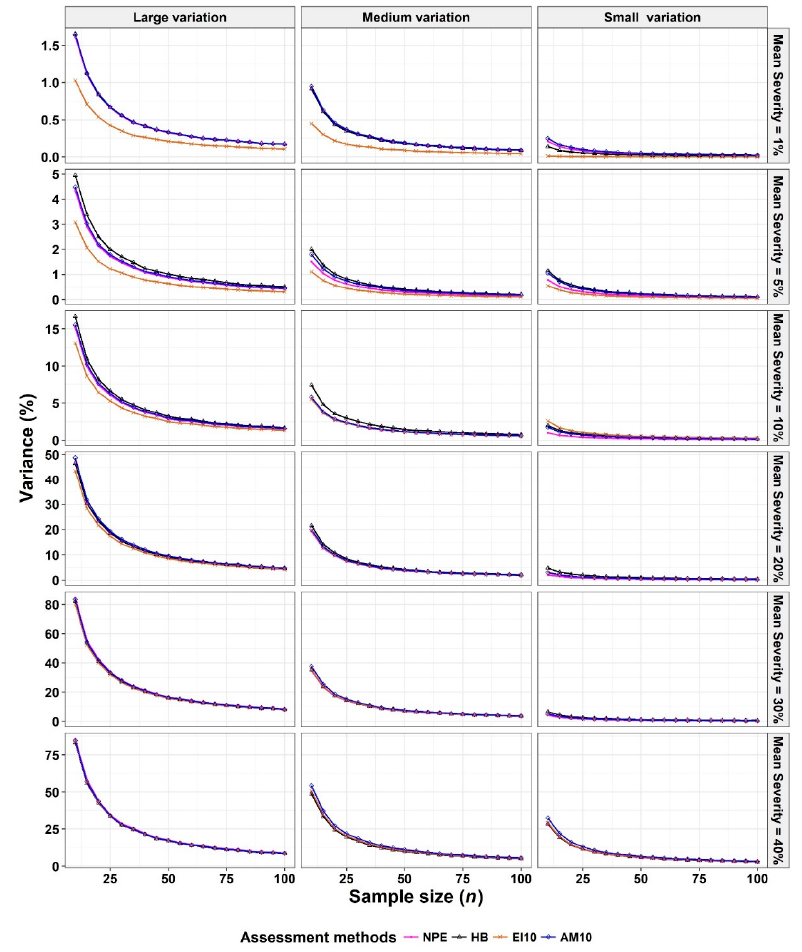
Figure 3. The relationships between the variance of mean disease severity estimates and sample size ( n ) (from n = 10 to 100 in n = 5 increments) for each of the different scales used, over a range of “actual” mean disease severities (1, 5, 10, 20, 30, and 40%) and variance (represented by large, medium, and small variation). The simulation process was repeated 10,000 times. Assessment methods: (i) NPE (nearest percentage estimate); (ii) HB (Horsfall-Barratt scale); (iii) AM10 (10% linear scale emphasizing severities ≤ 50% disease, and with additional intervals at severities <10%); (iv) EI10 (10% linear scale).